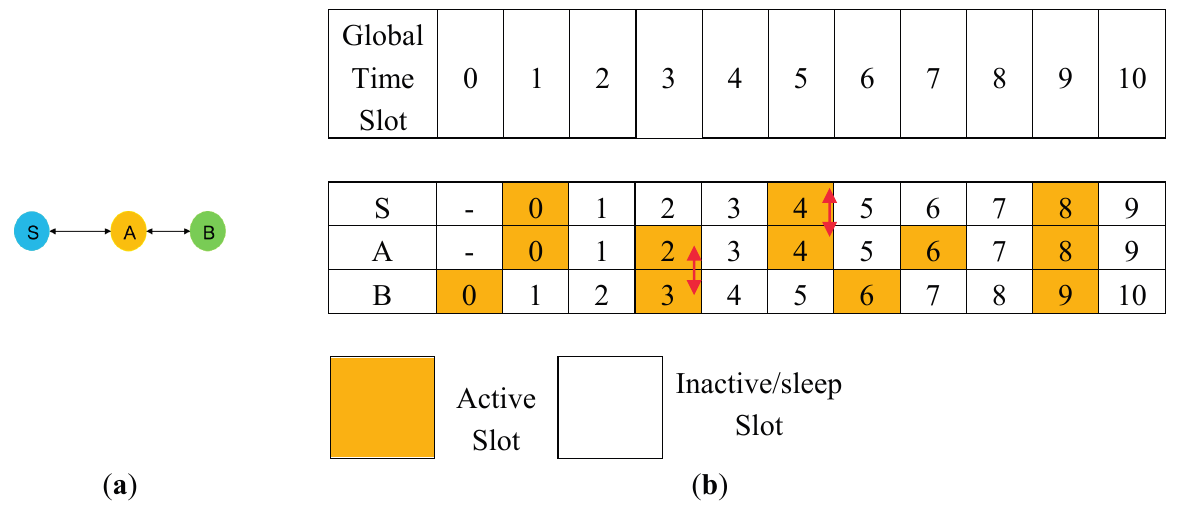
Figure 1. ( a ) Example of rendezvous maintenance; ( b ) example of neighbor discovery and rendezvous